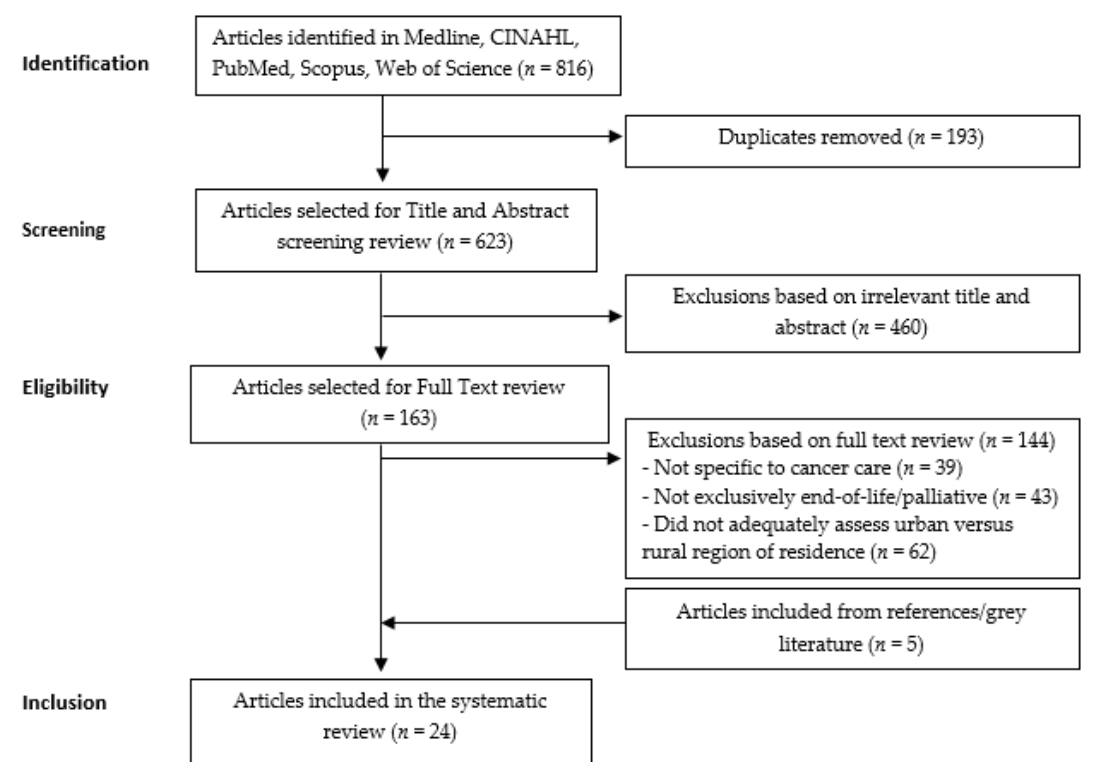
Figure 1. Flowchart of publications included in the systematic review.